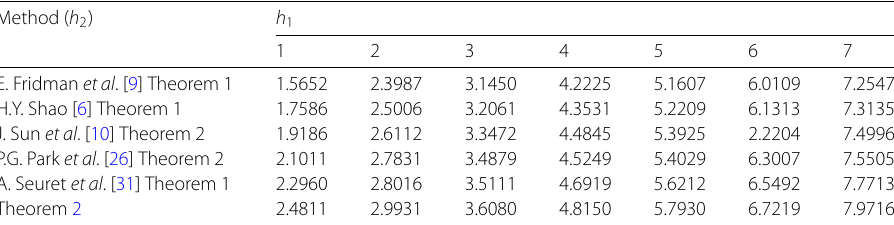
Table 3 The comparison results of upper bounds h 2 with different h 1 for μ = 0.5 (Example 2) Method ( h 2 ) h